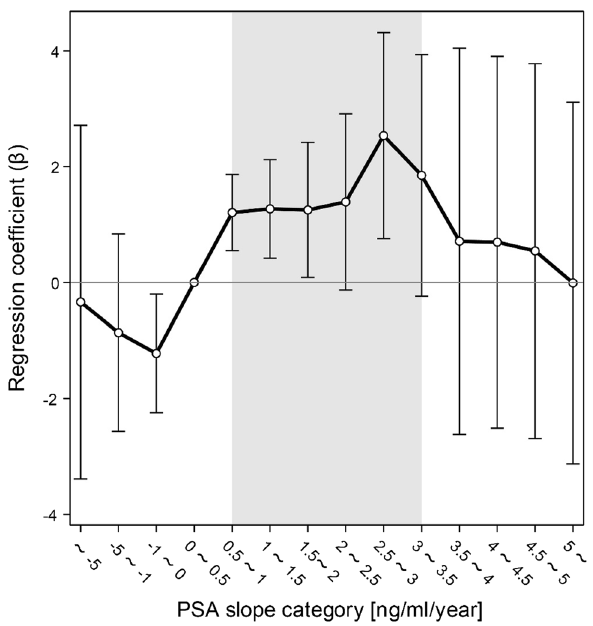
Figure 2. Linearity of the effect of PSA slope on the risk of prostate cancer (traning set). Logistic regression analysis was performed with PSA slope (in 0.5 increments) as the independent variable, and age and mean PSA value as covariates. We plotted the regression coefficient according to PSA slope. Our results showed an increased risk of prostate cancer for PSA slopes ranging between 0.5 and 3.5 ng/mL/year. PSA prostate-specific antigen.